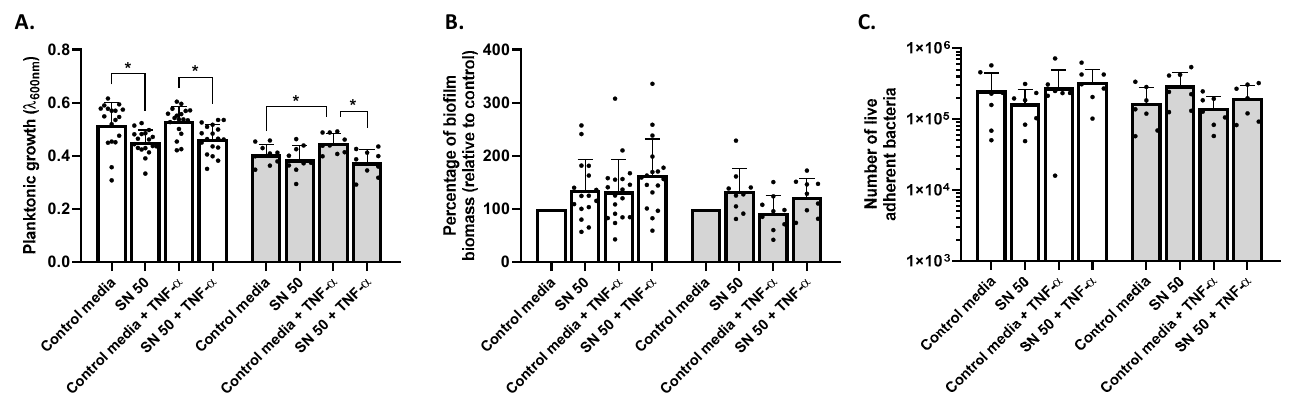
Figure 1. Impact of Saos-2 culture supernatant on S. aureus planktonic growth and biofilm biomass. Results represent planktonic growth ( A ), percentage of biofilm biomass relative to control media ( B ), and number of adherent bacteria ( C ) for SH1000 (white histogram) and USA300 (grey histogram). Control media (50% [DMEM + 10% FBS] and 50% MM), SN 50 (50% Saos-2 culture supernatant and 50% MM), Control media + TNF- α (50% [DMEM + 10% FBS + 20 ng/mL TNF- α ] and 50% MM), or SN 50 + TNF- α (50% [Saos-2 challenged with TNF- α culture supernatant + 20 ng/mL] and 50% MM). n = 7 to 18. * = p < 0.05.